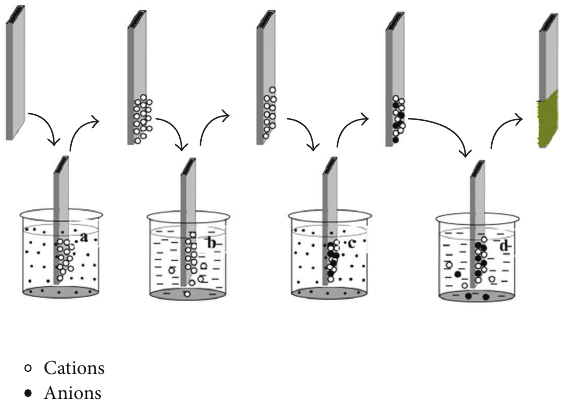
Figure 9: Schematic representation of SILAR method